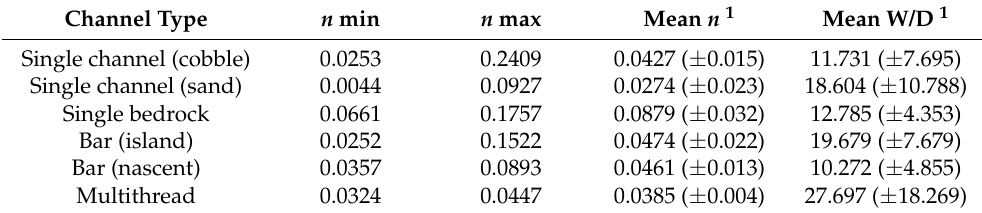
Table 5. Manning’s values and W/D ratios for channel types using the Limerinos equation (1970).